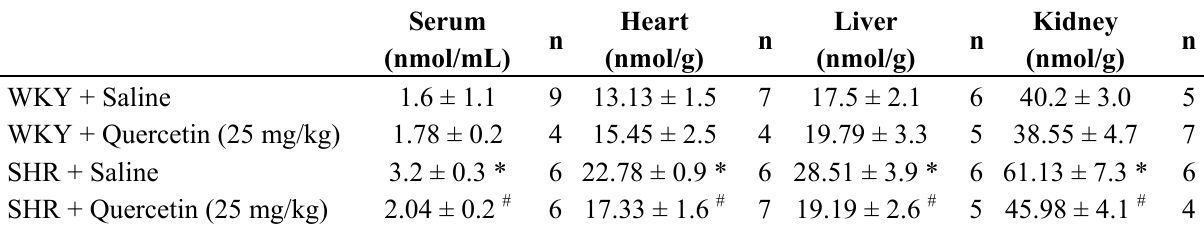
Figure 4. Lipid peroxidation (TBARS) in serum and organs of all four groups (WKY + saline, WKY + Quercetin 25 mg/kg; SHR + saline, SHR + Quercetin 25 mg/kg). Serum levels of TBARS ( A ); TBARS in the heart ( B ); TBARS in the kidney ( C ); TBARS in the liver ( D ). * p < 0.05, when compared to WKY + saline group and # p < 0.05, when compared to SHR + saline